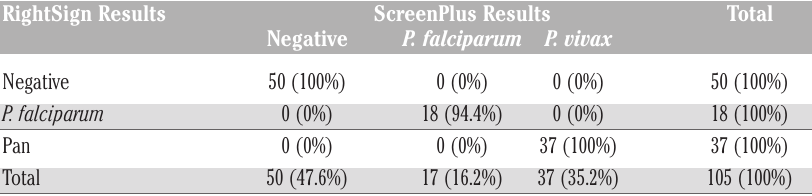
Table 10. Comparison of species detection between ScreenPlus and